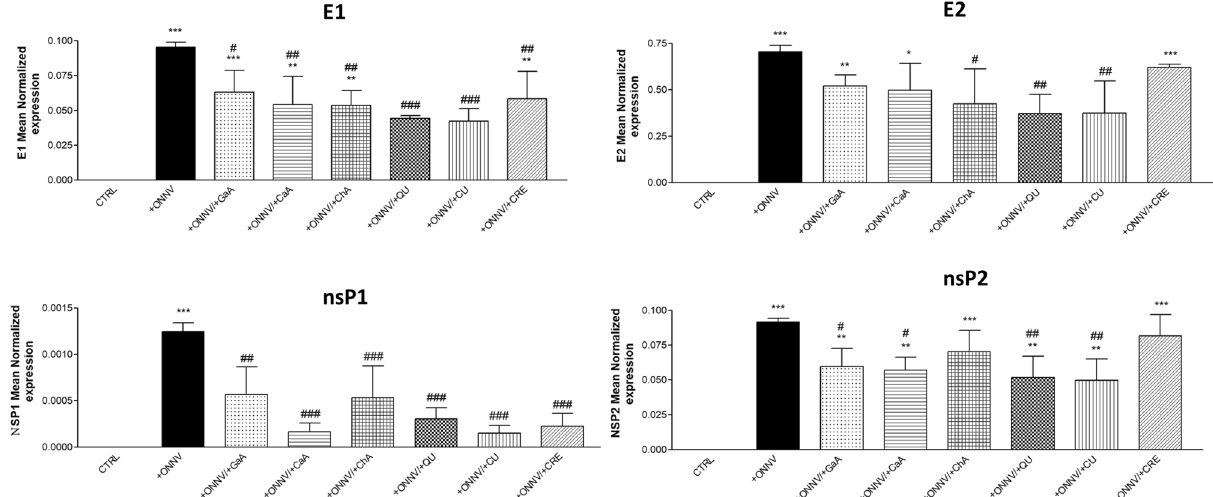
Figure 4. Quercetin impairs ONNV replication in HSF cells. HSF cells were infected by ONNV (MOI 1) co-treated or not with phenolic compounds (10 µM) for 24 h. Then, RNA was collected and E1, E2, nsP1 and nsP2 gene expression levels were determined by qRT-PCR. Reported values are means ± SEM of three independent experiments. p value was calculated using the Bonferroni multiple comparison test: *p < 0.05,